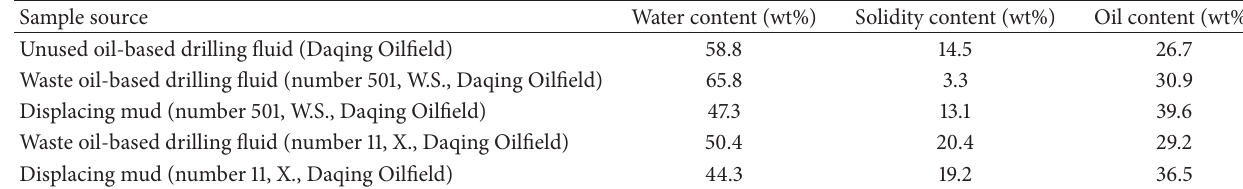
Table 1: Content of each composition of waste oil-based drilling fluid.